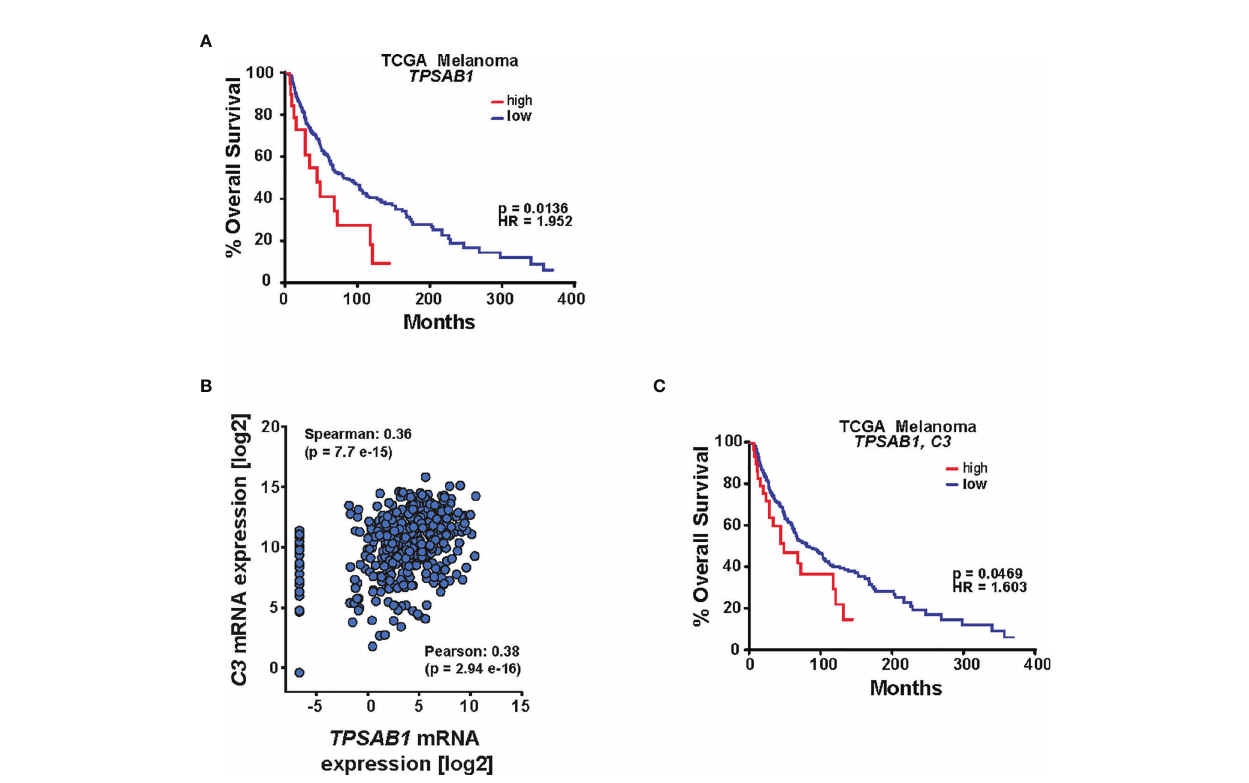
FIGURE 8 | MCs expressing C3 are linked to low survival rates in melanoma patients. (A) Kaplan – Meier analysis of The Cancer Genome Atlas (TCGA) melanoma patient cohort. Differences in overall survival for patients whose tumors express high or low levels of TPSAB1 are shown. The data were analyzed for mRNA expression ( z -score 2.0) in cBioPortal, and survival data were extracted and analyzed in GraphPad Prism. Log-rank (Mantel – Cox) test was used; p = 0.0136 and hazard ratio (HR) = 1.952. (B) Correlation analysis of the TCGA melanoma patient cohort for C3 and TPSAB1 . The TCGA dataset was interrogated in cBioPortal and the data were extracted and further analyzed in GraphPad Prism. Spearman as well as Pearson correlation is indicated. (C) Kaplan – Meier analysis of the TCGA melanoma patient cohort. Differences in overall survival for patients whose tumors express high or low levels of C3 and TPSAB1 were analyzed. cBioPortal assessing patient survival for C3 and TPSAB1 mRNA expression ( z -score 2.1). Data were extracted and further analyzed in GraphPad Prism. Log-rank (Mantel – Cox) test was used; p and hazard ratio (HR) values are